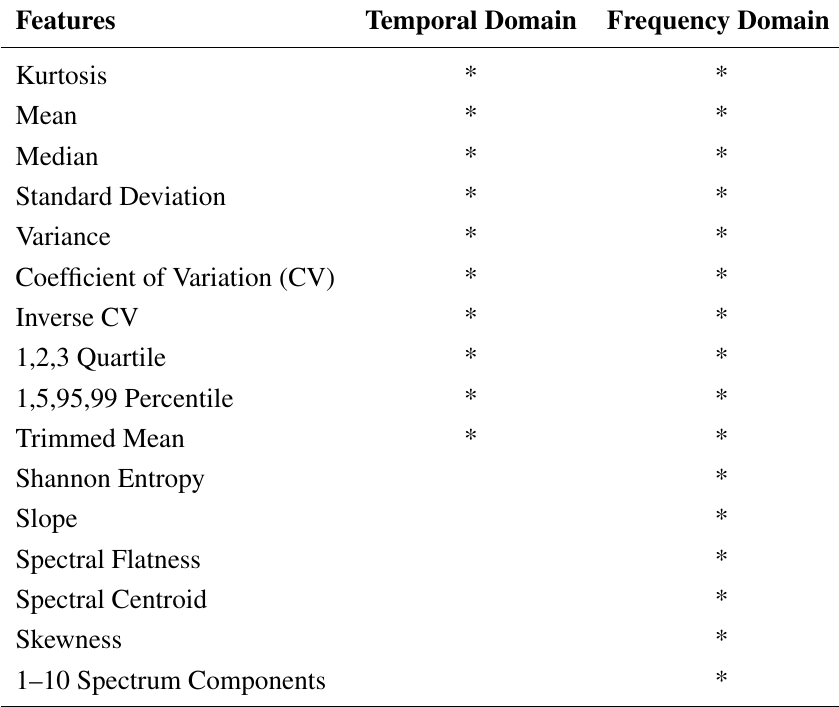
Table 1. Features